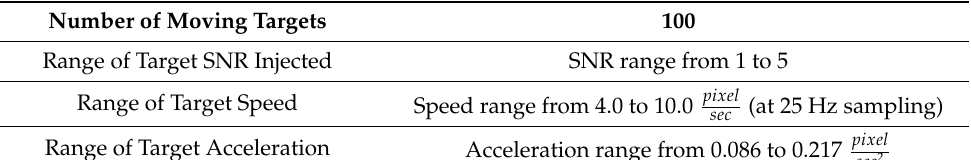
Table 1. Simulation Scenarios.